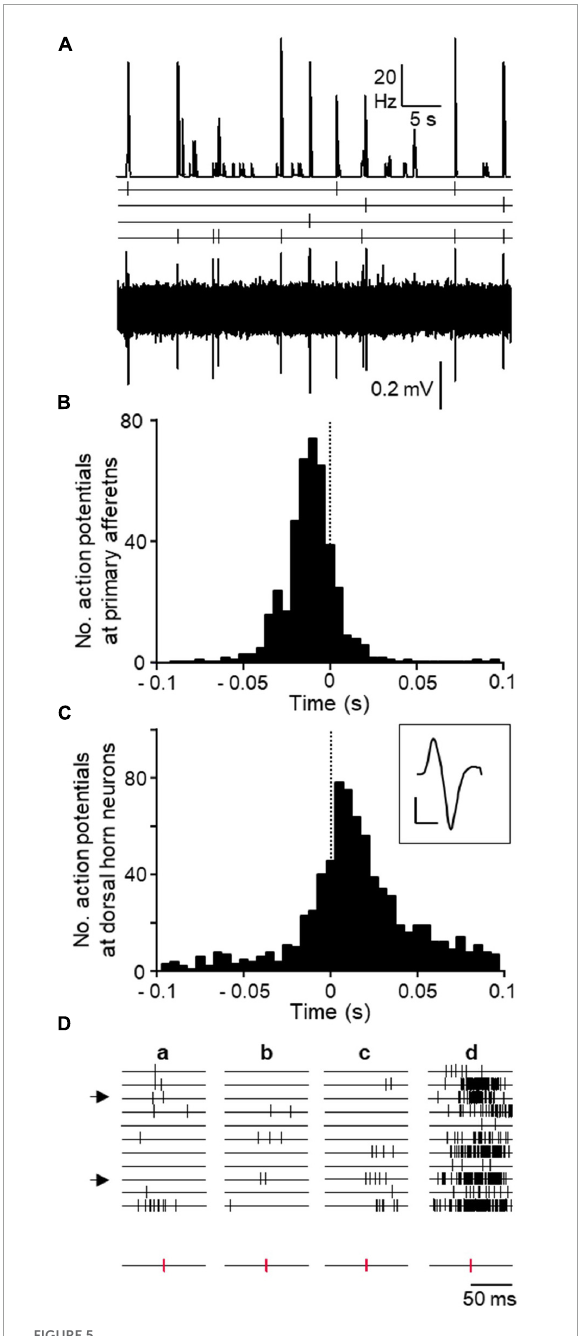
FIGURE5 Correlation between DRRs and spontaneous spikes from dorsal horn neurons. (A) Original recordings showing the coincidence in time between population bursts (top trace) and action potentials recorded from 4 isolated primary afferents (time stamps and original recording below). This experiment was performed on tissue from a treated animal. (B) Cross-correlograms from the same experiment showing the distribution of action potentials from all 4 primary afferents around the population bursts mark (time 0 and dotted line). (C) Cross-correlograms from a different experiment showing action potentials from dorsal horn neurons taking